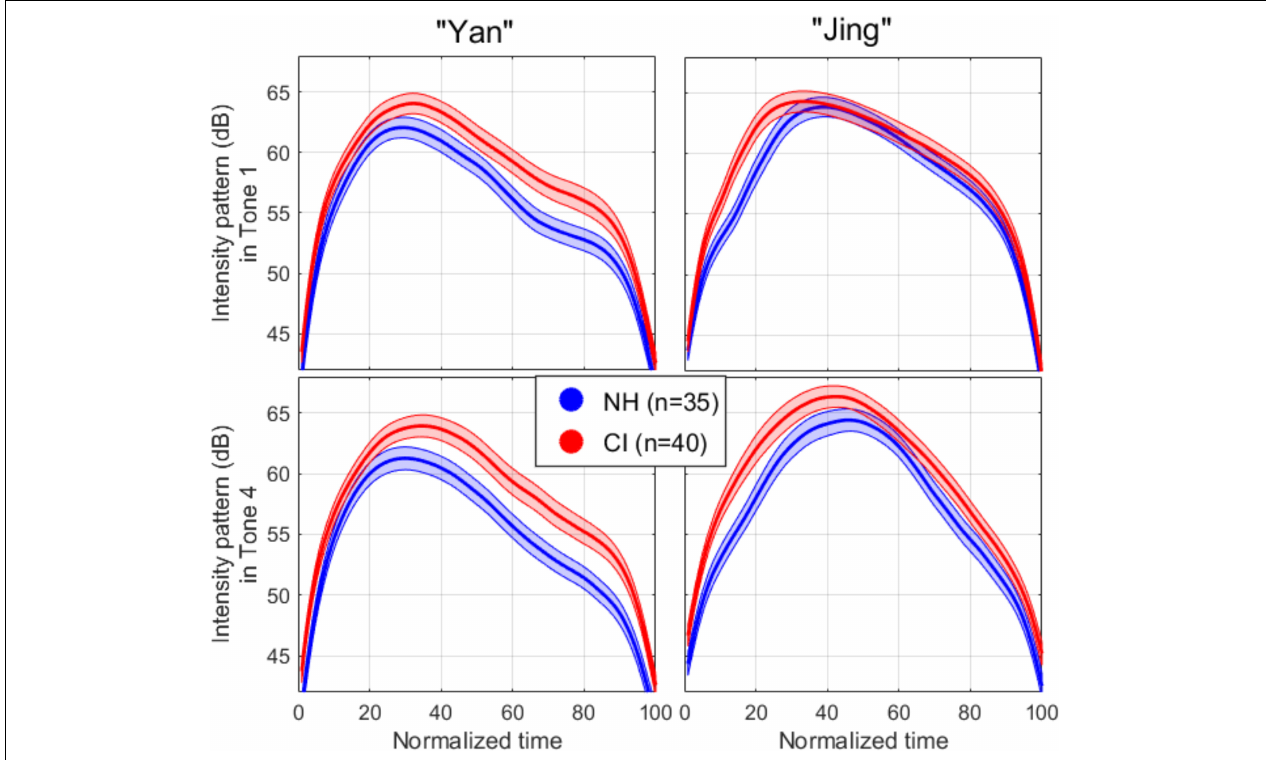
FIGURE 3 | Mean (thick line) and one standard error (areas) for the intensity patterns extracted for each syllable when producing “yan-jing” with Tone 1 (top panels) vs. Tone 4 (bottom panels). The patterns were delimited in time with a 20-dB cutoff from the intensity peak, and the resulting duration was normalized from 0 to 100% of the total duration to enable averaging across repetitions and